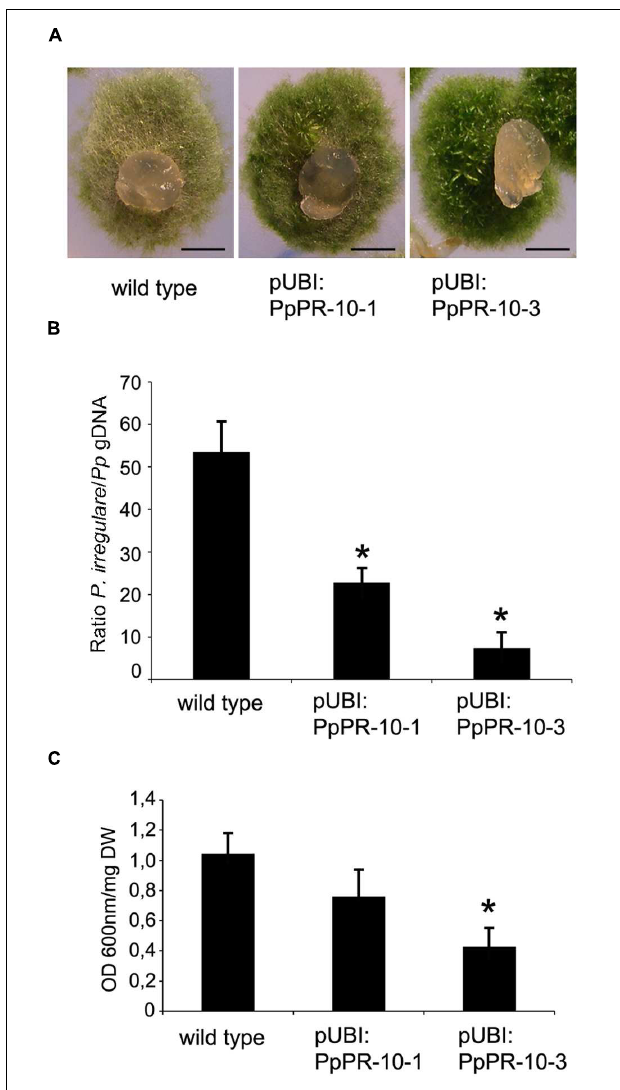
FIGURE 5 | Symptom development and mycelium growth of P. irregulare in wild type and PpPR-10 overexpressing moss lines. (A) Symptom development in wild type, pUBI:PpPR-10-1 and pUBI:PpPR-10-3 moss colonies. (B) P. irregulare DNA levels were estimated by qPCR analysis. Ratios of P. irregulare to P. patens ( Pp ) gDNA were determined by qPCR with primers ITSf/ITSr and EFf/EFr, respectively. The results and standard deviation of three independent triplicate experiments are shown. (C) Measurement of cell death by Evans blue staining 24 h after inoculation of wild type, pUBI:PpPR-10-1 and pUBI:PpPR-10-3 moss colonies with P. irregulare . Data were expressed as the optical density (OD) at 600 nm per milligram of dry weight (DW). Values are means with standard deviations of six independent replicate moss samples. Experiments were repeated trice with similar results. Asterisks indicate a statistically significant difference between the wild type and overexpressing PpPR-10 plants [Students t -test, P < 0.005 ( ∗ )]. The scale bars represent 0.5 cm.